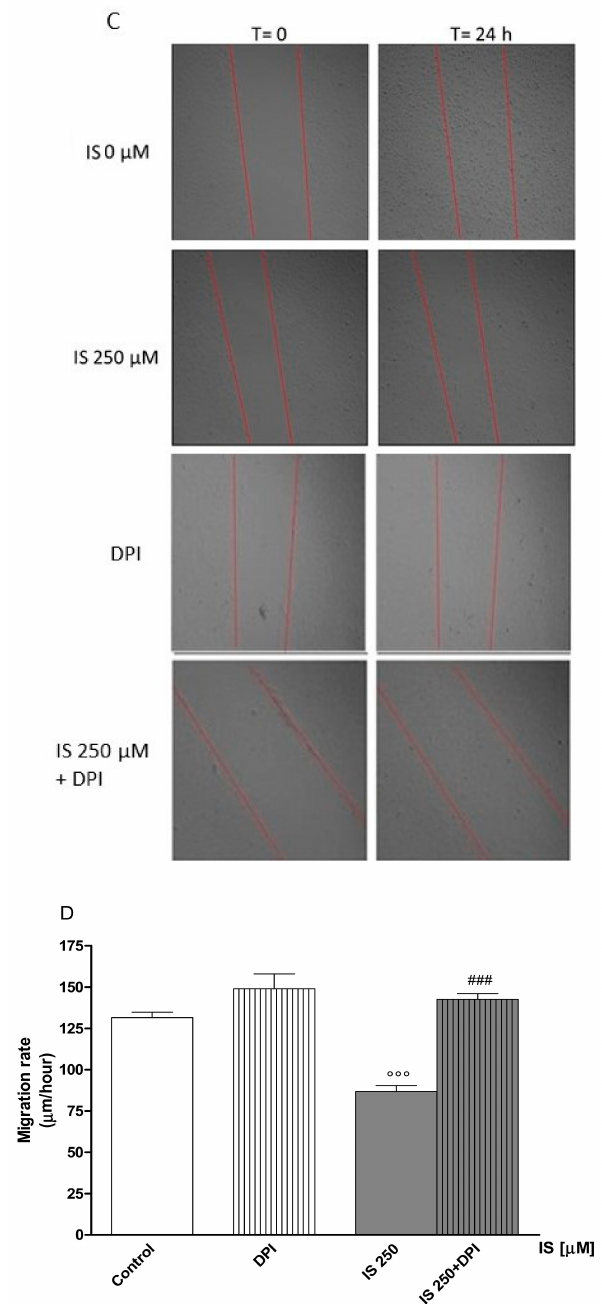
Figure 3. Pictures representing the wound repair induced by mechanical scratch in IEC-6 after 24 h from IS treatment (31.2–250 µ M; A ), and the quantitative analysis expressed as IEC-6 migration rate 24 h from the wound ( B ). Representative images of wound repair, in the presence of DPI and IS (250 µ M; C ) and its quantitative analysis expressed as IEC-6 migration rate after 24 h from the wound ( D ; n = 15). Values are expressed as migration rate. ◦◦◦ and ◦ denote respectively p < 0.001 and p < 0.05 vs. control cells. ### denotes p < 0.001 vs. IS